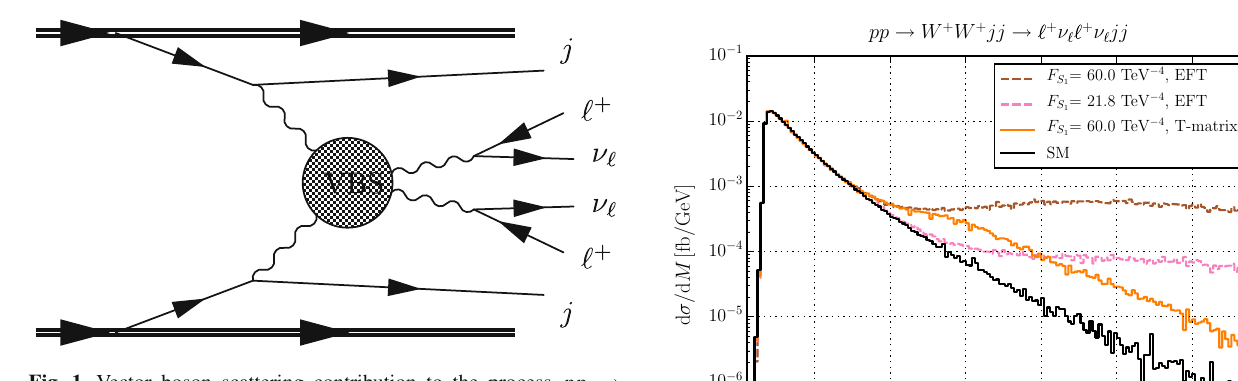
√ s = 8 TeV data Fig. 2 Differential cross section as a function of the invariant mass m VV of the weak vector bosons for pp → (cid:6) + ν (cid:6) (cid:6) + ν (cid:6) jjX . The solid black line represents the SM, while the dashed pink and dashed brown lines show the EFT cross section for the F S 1 = f S coupling. The solid orange line shows the T-matrix unitarized curve with the same fiducial cross section as the pink pure EFT curve. Cuts defining the fiducial region are given in Eq.